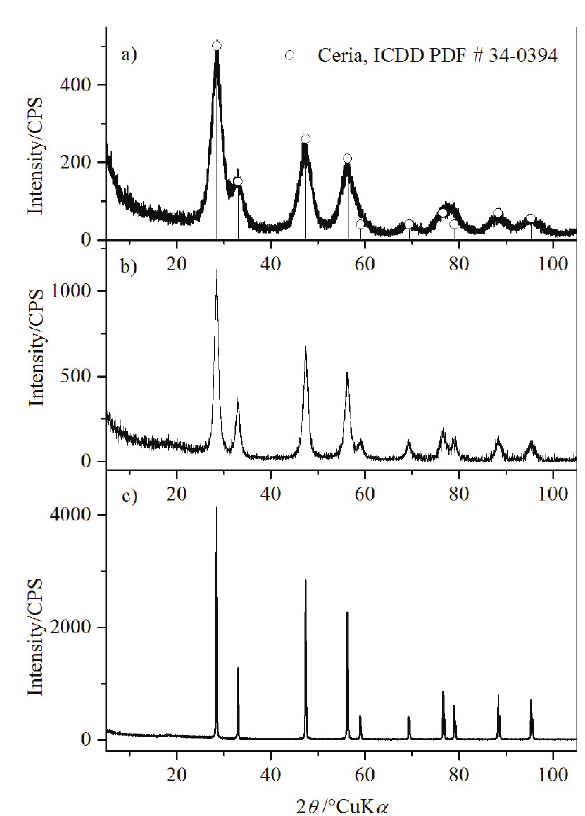
Fig. 1 – The diffraction pattern of a) as-prepared catalyst, b) catalyst heated to 500 °C, c) catalyst heated to 1000